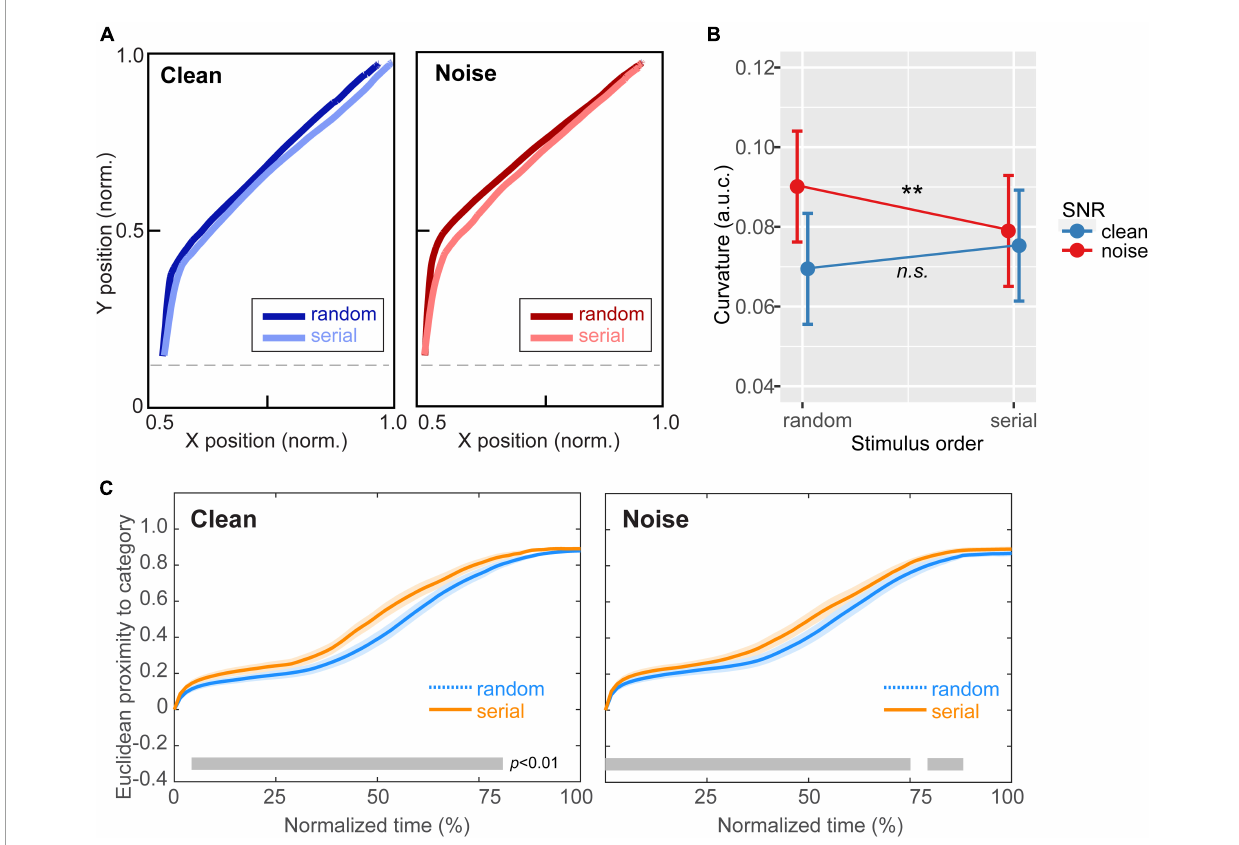
FIGURE4 Continuous dynamics in speech categorization reveal perceptual warping helps hone categories in noise. (A) Mousetracks toward the category endpoint [mean of Tk1 (mirrored) and Tk7] for clean and noise-degraded speech for random and serial token ordering. (B) Track curvature was invariant to stimulus order for clean speech. However, amidst noise, mouse responses were less bowed (i.e., more directed) to the speech category under serial presentation. (C) Proximity of the mouse cursor to target speech over normalized time (Spivey et al., 2005). For both clean and noisy speech identification, the mouse remained closer to the ultimate selection in serial vs. random order, indicating increased perceptual attraction to the phonetic category (i.e., perceptual warping). However, stimulus order effects emerged earlier and persisted later in the time course of perceptual decision in the noise condition [gray bars = running t-test, p < 0.01, paired samples; (Guthrie and Buchwald, 1991)]. ** p < 0.01. Shading = ± 1 SEM. Error bars = 95%